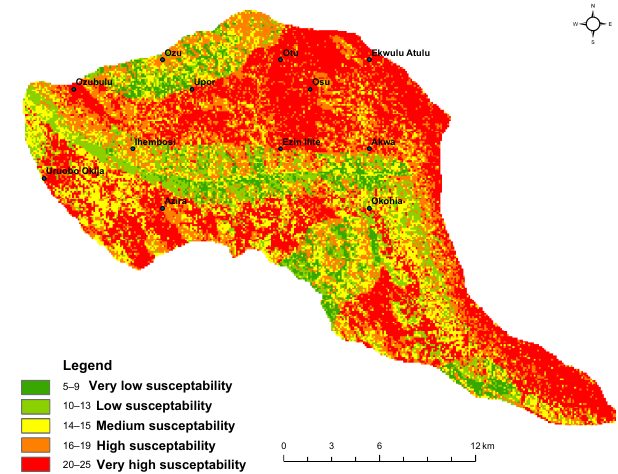
Figure 9. Areas susceptible to